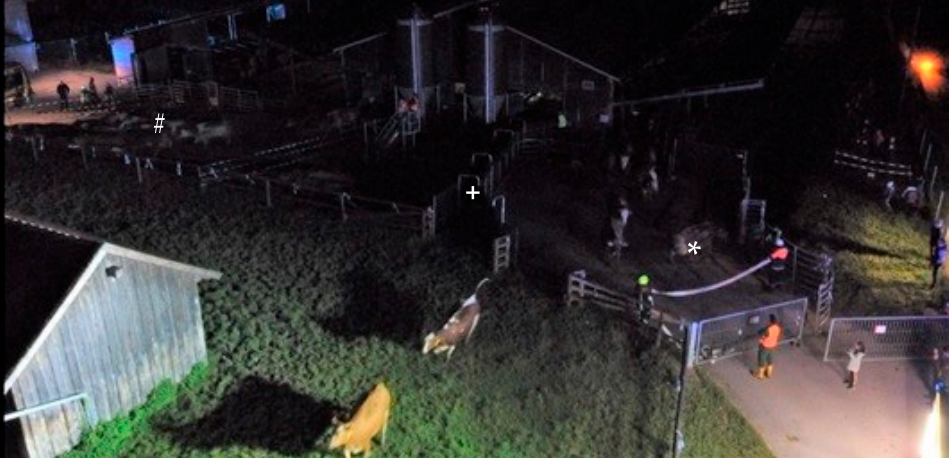
Figure 4. Cows of NonH (r.) leaving the barn with a Brown Swiss (*) turning around on the right side. Cows of HABIT leaving the barn in a bulk in the far left (#). Race of NonH-R in the middle with no cow leaving the barn yet (+).